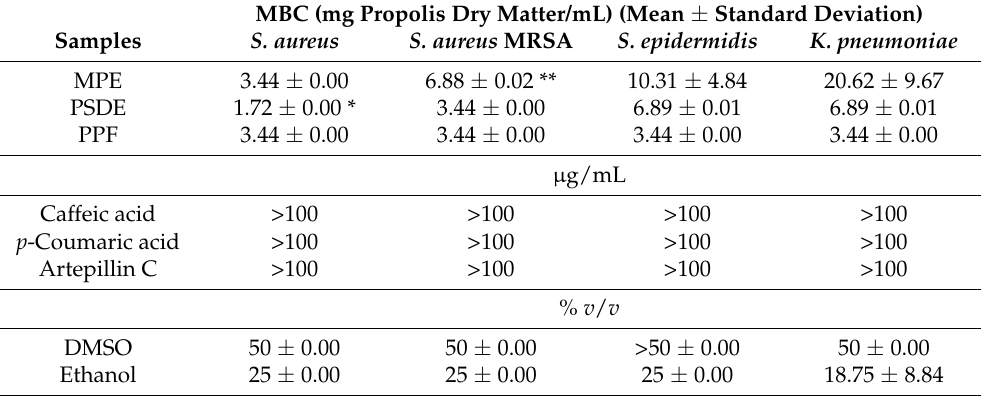
Table 4. Minimal bactericidal concentration (MBC) determination for the extracts and the compounds selected in this study, followed by the solvents used for the solubilization of some samples according to methodology